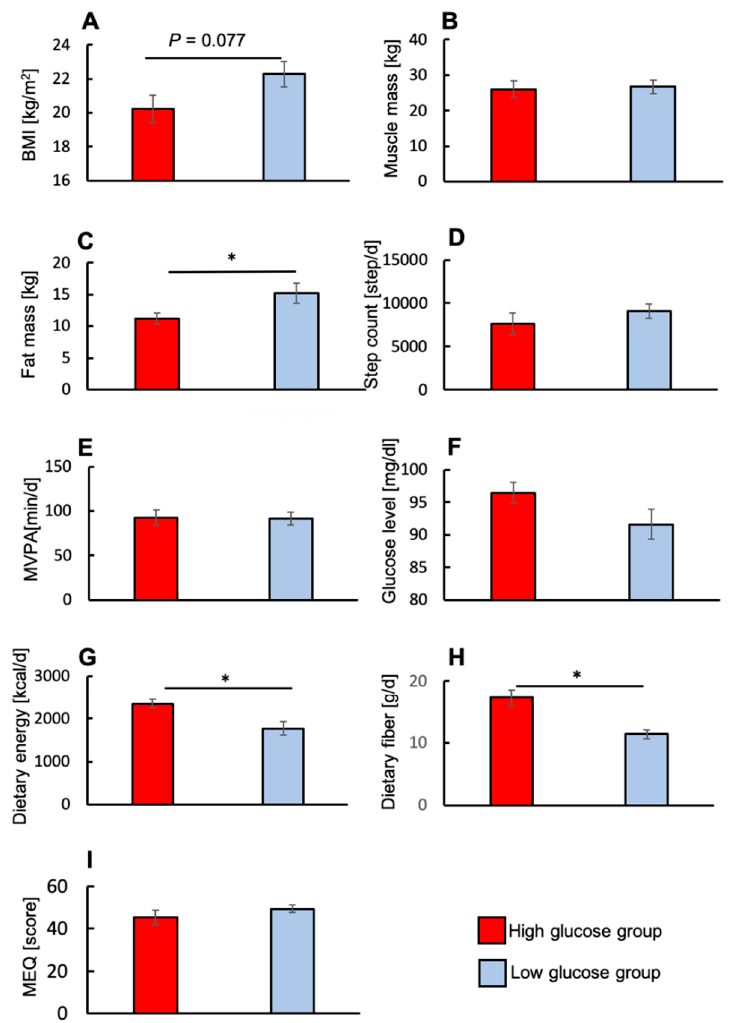
Figure 5. Differences in physiological factors for the high- and low- glucose groups. Body Mass Index (BMI) ( A , N = 18), muscle mass ( B , N = 18), fat mass ( C , N = 18), step count ( D , N = 18), moderate-to-vigorous physical activity (MVPA) ( E , N = 18), glucose level on daily basis ( F , N = 15), dietary energy ( G , N = 15), dietary fiber ( H , N = 15), Morningness–Eveningness Questionnaire (MEQ) ( I , N = 18). Values are means ± standard errors. * p < 0.05, ** p < 0.01.